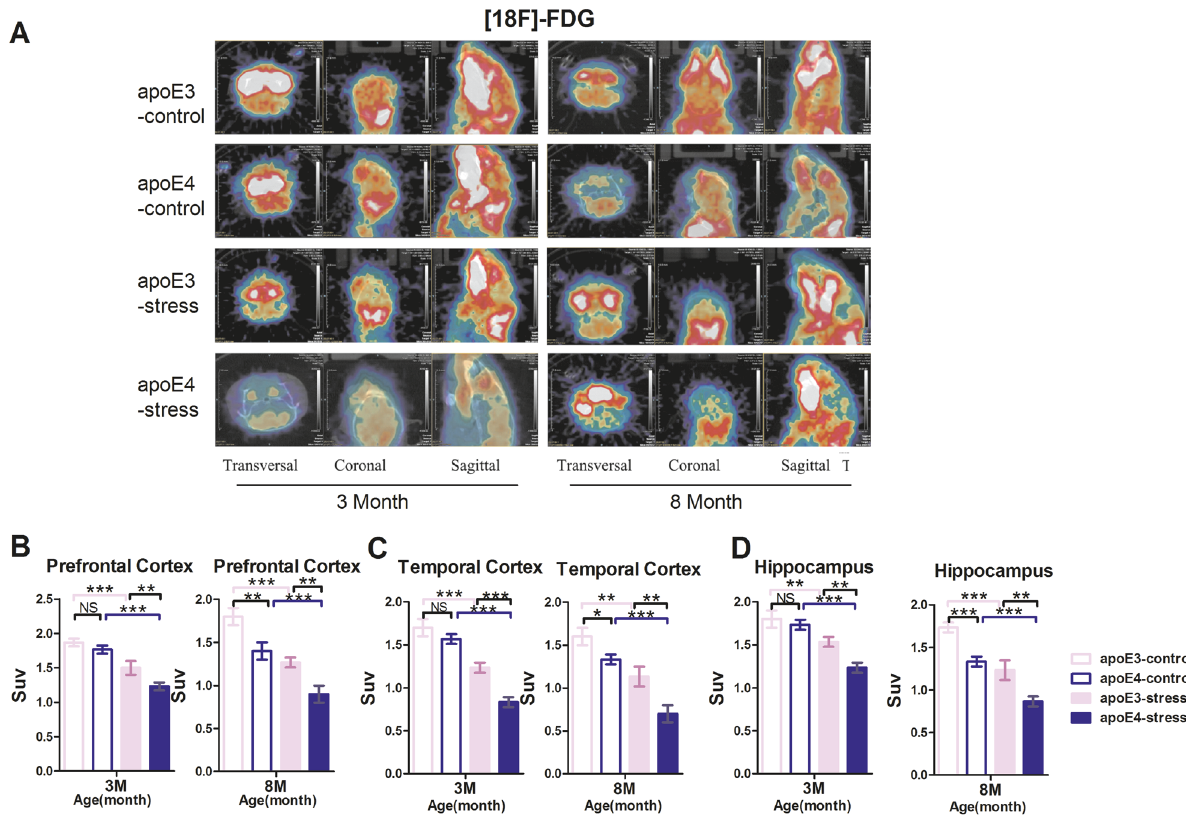
Fig. 2 The APOE ε 4 allele-induced glucose metabolism declines in the prefrontal cortex and the temporal cortex in an age-dependent manner. A The reconstruction of PET-CT images demonstrated a remarkable [18F] FDG uptake in the prefrontal cortex and temporal cortex. B – D Standard intake value (SUV) chart of the prefrontal cortex, temporal cortex and hippocampus, respectively. * p < 0.05, ** p < 0.01, *** p < 0.001, by two-way ANOVA with Tukey ’ s Multiple Comparisons Test ( n = 3). NS not signi fi cant ( p > 0.05). Data are presented as the mean ±